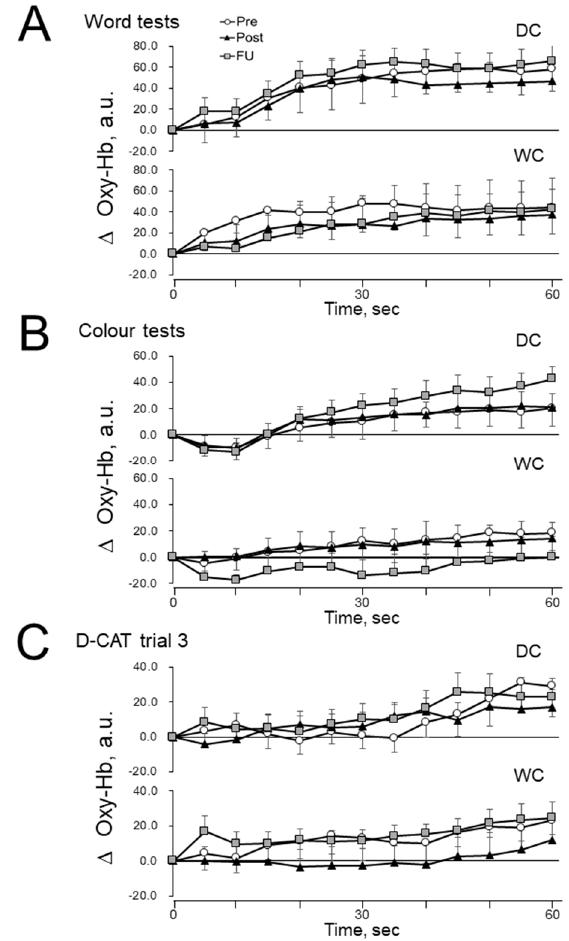
Figure 4. The e ff ects of dark chocolate (DC) and white chocolate (WC) intake on PFCBF during the cognitive function tests. Average of oxygenated hemoglobin (Oxy-Hb) during the modified SCWT in word tests at Pre, Post, and FU for the DC group (( A ), upper panel) and WC group (( A ), lower panel). Average of Oxy-Hb during the modified SCWT in color tests at Pre, Post, and FU for the DC group (( B ), upper panel) and the WC group (( B ), lower panel). Average of Oxy-Hb during the D-CAT at Pre, Post, and FU for the DC group (( C ), upper panel) and the WC group (( C ), lower panel). Variables are expressed as changes ( ∆ ) from the baseline at the rest period in each trial. Means ± SEM bars are presented every 5